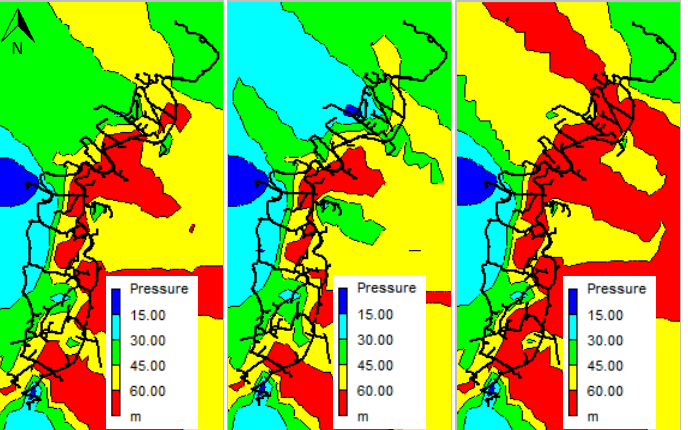
Figure 12. Pressure variation in the Gaula WDN—average, peak, and maximum pressure scenarios (status quo).